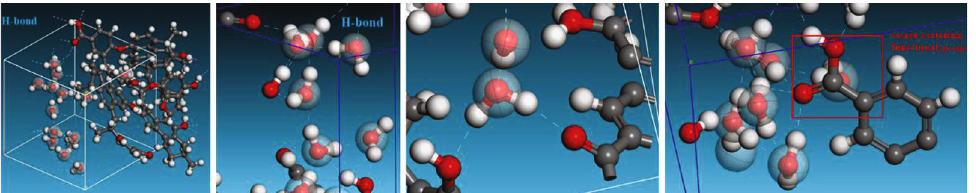
Figure 3: H-bonds in the binary system of water-long- fl ame coal. Blue dashed lines represent